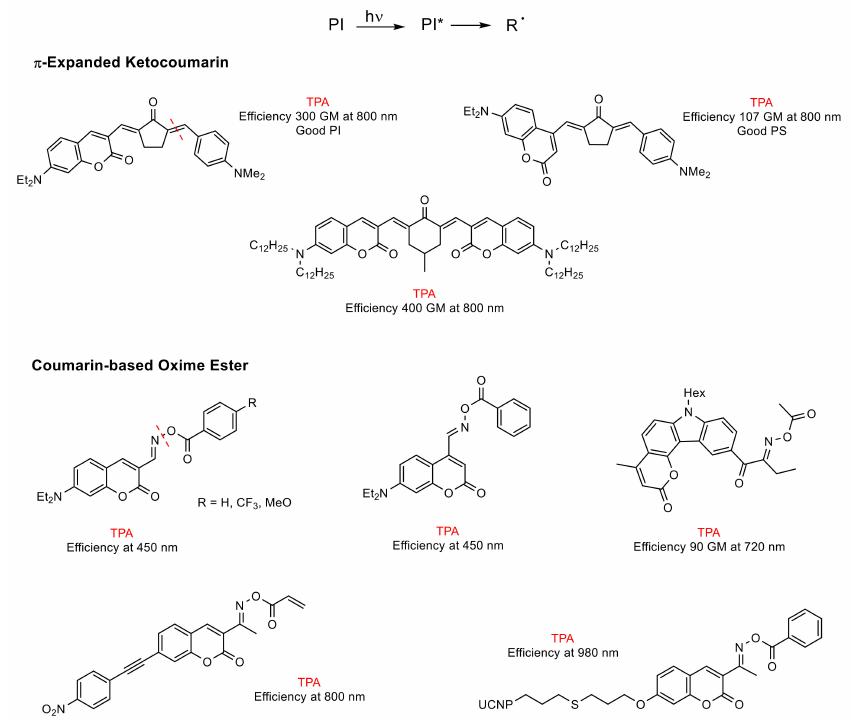
Figure 10. Unimolecular coumarin-based photoinitiators (PIs). The asterisk (*) denotes the excited state of the molecules.